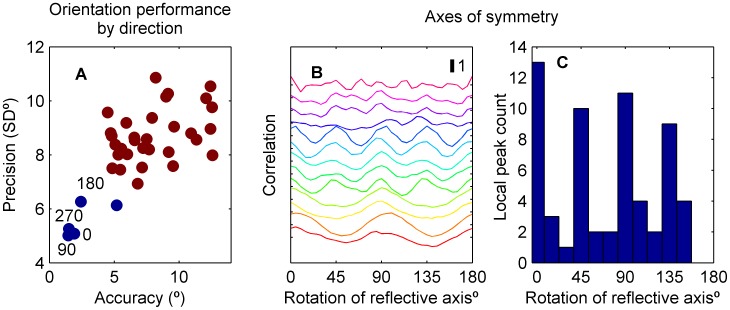
Analyses of cardinal-centric symmetry in orientation performance.(A) Comparison of population-mean precision and accuracy metrics illustrates that cardinal directions are associated with both higher accuracy and precision. Cluster analysis to the level of two groups resulted in one cluster containing the four cardinal directions and 300°. (B) The circular cross-correlation of each participants' direction-dependent orientation bias with its reflection – a measure of symmetry in the anisotropic judgement of directions. Each colour corresponds to a different participant, and curves have been vertically offset for clarity. Some participants exhibited correlations with 90° periodicity whereas others with 45° periodicity. In both cases, the highest correlations tended to occur across the cardinal axes. The histogram counts all local maxima in the cross-correlations of each participant; the most common axes of symmetry was indeed in the cardinal planes (0° and 90° rotation).